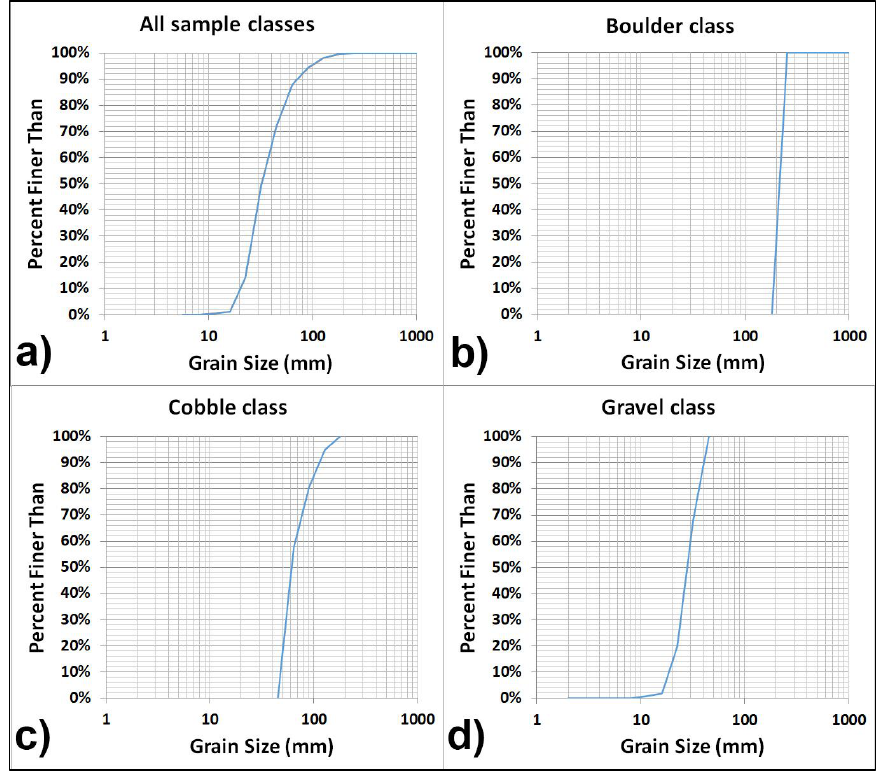
Figure 6. Cumulative grain-size distributions obtained by grid sampling of 11 grids concerning: all samples count ( a ), only boulder count ( b ), only cobble count ( c ), only gravel count ( d ).